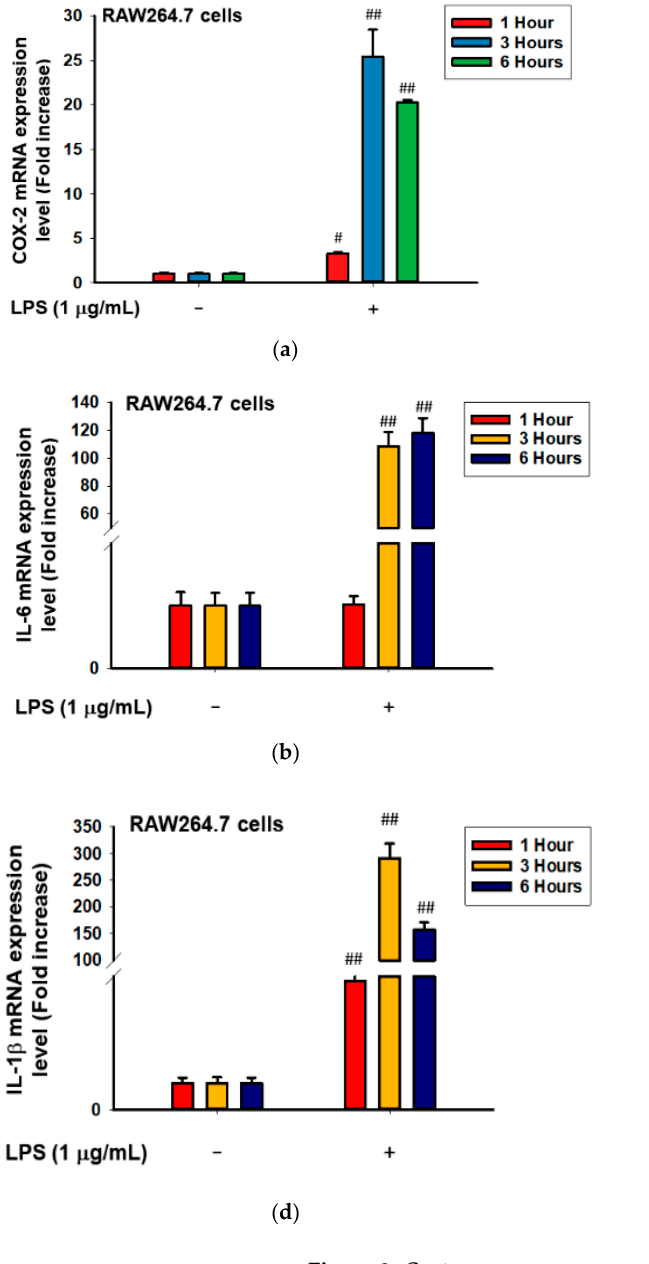
Figure 2. Effect of MLK3 on the phosphorylation of AP-1 subunits, MAPK, and MAPKK. ( a – e ) The phospho- and total forms of MAPK, MAPKK, and AP-1 subunits were detected from whole cell lysates of HEK293 cells transfected with Myc-MLK3 (1 μ g/mL) for 36 h by immunoblotting analysis.